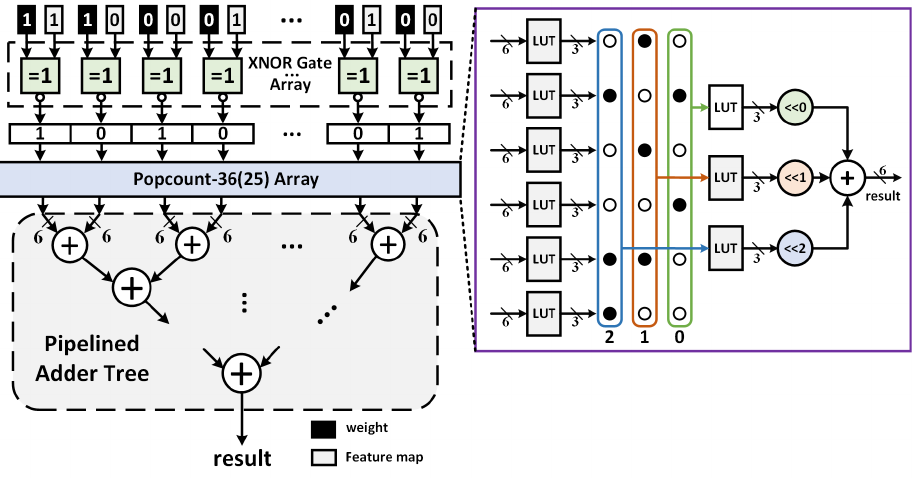
Figure 7. The overall architecture of XNOR-Popcount computing circuit unit, and the right purple block represents its internal architecture of Popcount-36(25)